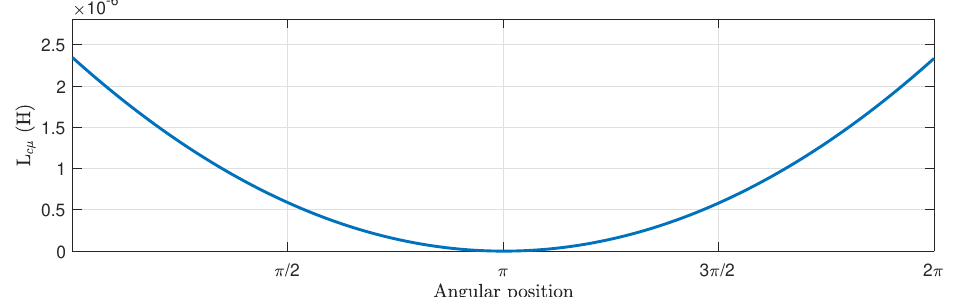
Figure 13. Main inductance between two conductors of the simulated machine, located in the air gap, as a function of their angular separation.